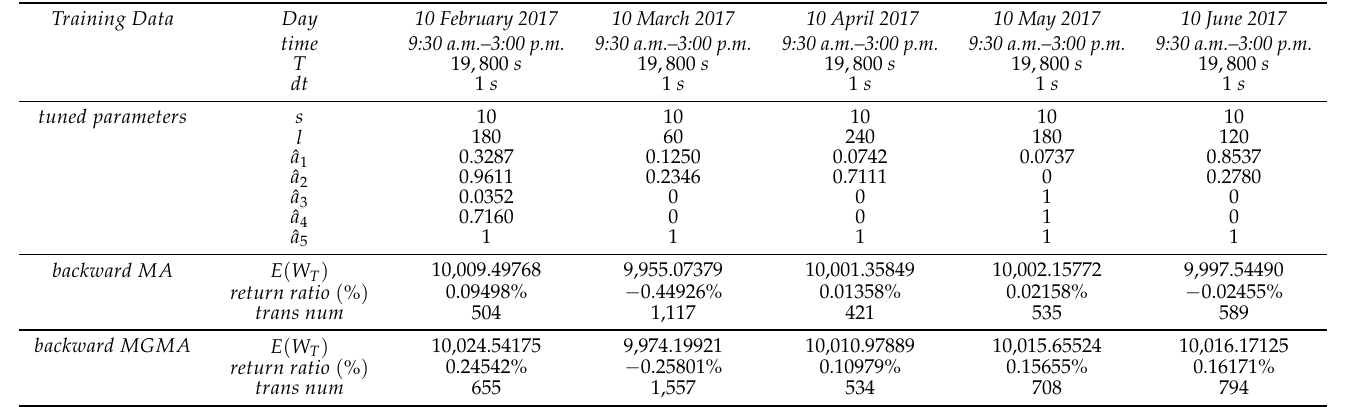
Table 8. Case 1—MGMA strategy performance summary for QQQ ETF and SPY ETF on day 1